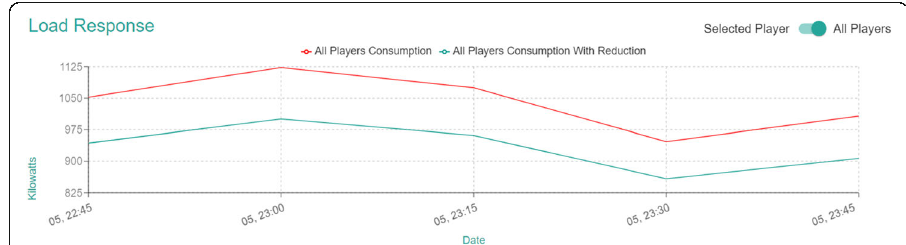
Fig. 12 Reduction graph (All